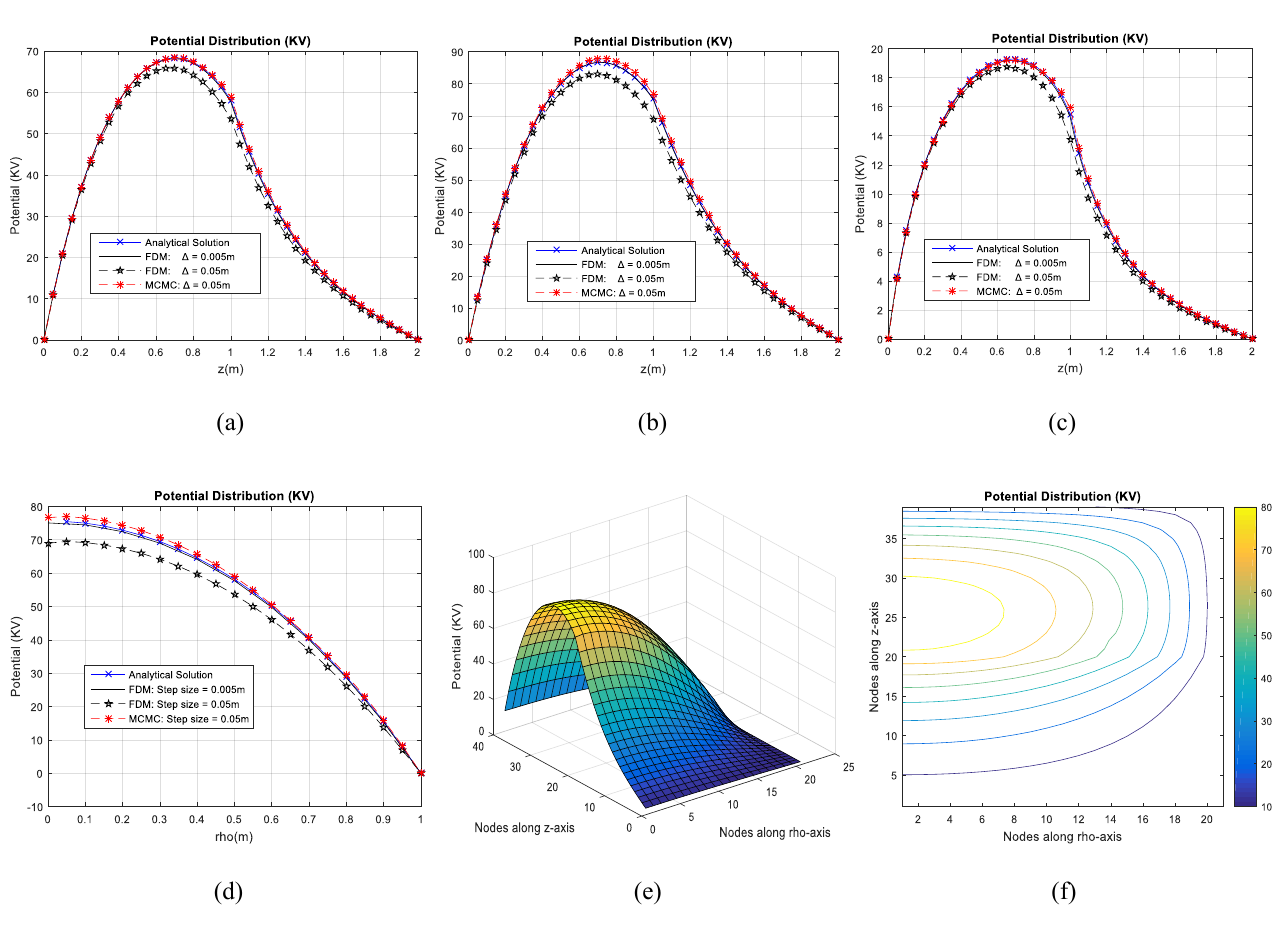
Figure 5. Potential Distribution along (a) (d) Media interface, (e) Surface plot (f) Contour Plot for Poisson’s equation in Inhomogeneous Axisymmetric Domain.